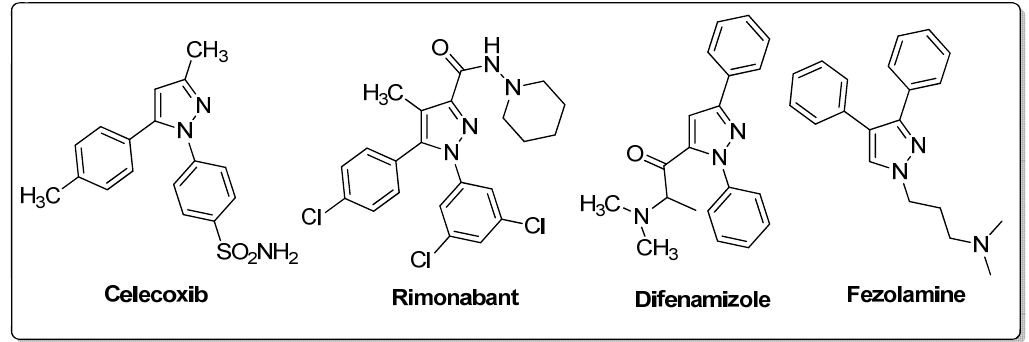
Figure 23 . Pyrazole ‐ based clinical drugs. Figure 23. Pyrazole-based clinical drugs.